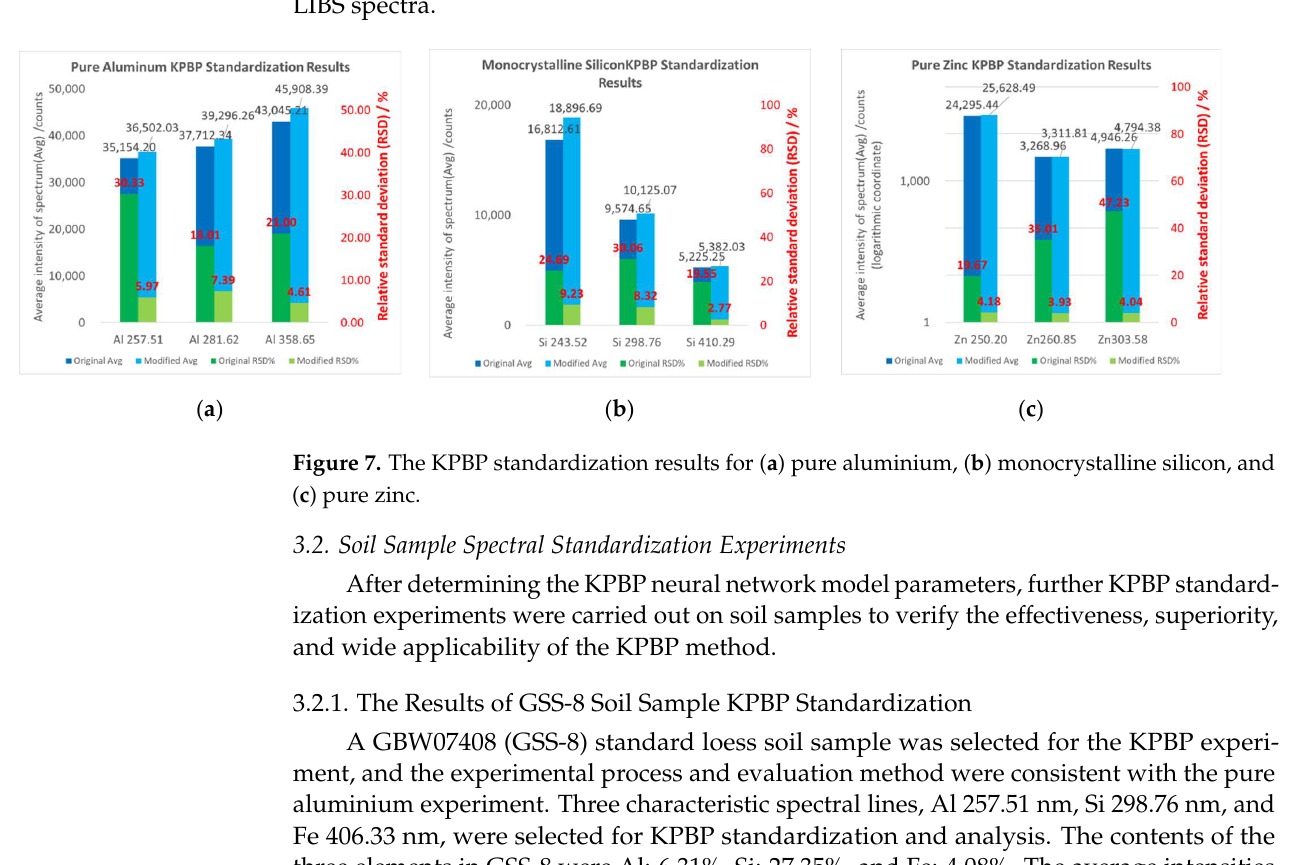
Figure 8. The KPBP standardization results of the GSS-8 soil sample.